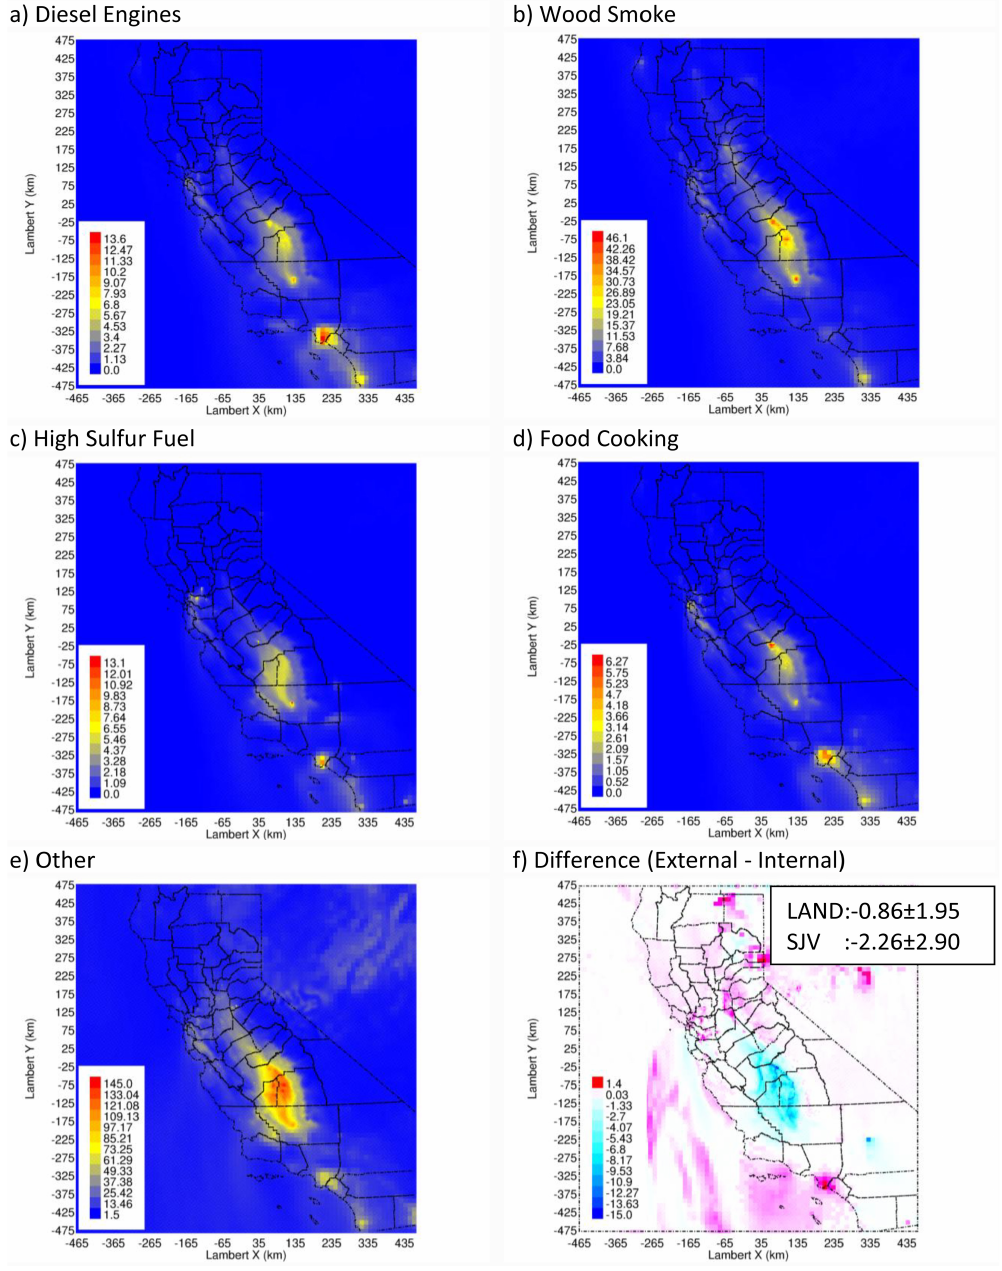
Fig. 10. 24h averaged PM 2 . 5 concentrations associated with primary particles emitted from different sources predicted by the external case (a–e) on 24 December 2000 and difference between external case and internal case (f) . Units are µgm − 3 . Note that the maximum value for each panel is adjusted to best illustrate the spatial patterns. Averaged differences over land and the SJV covered by the 4km domain are shown in the text